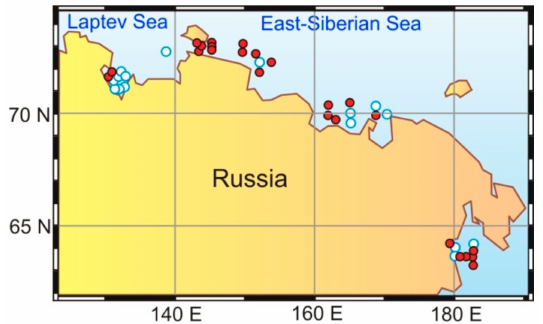
Figure 3. Location of stations on the Russian Arctic shelf (circles). Open blue circles are stations where anomalous echo durations ( ∆ > 4 ms) were